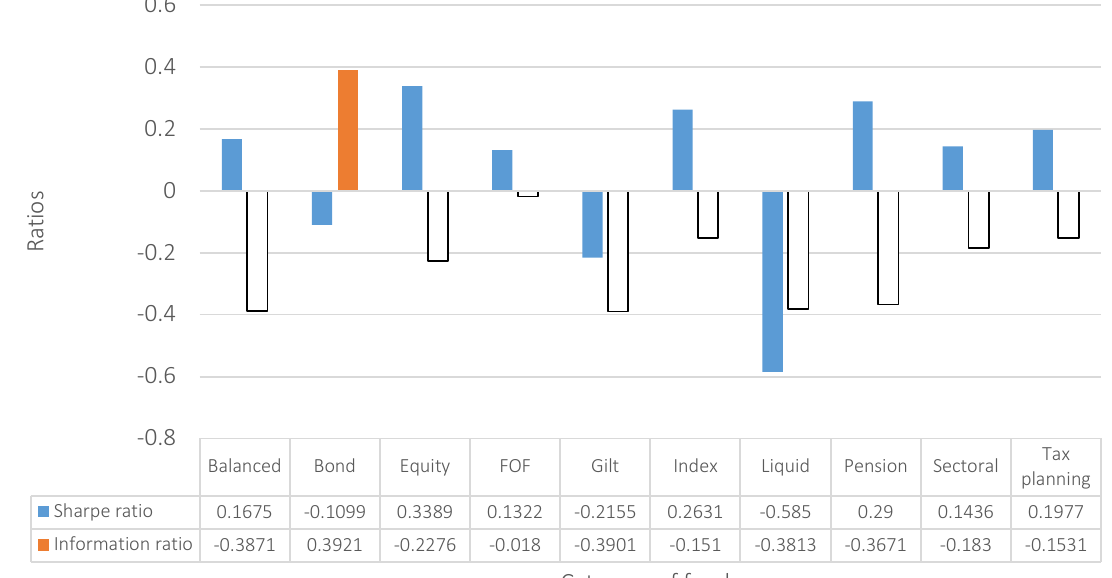
Figure 1. Sharpe ratio and Information ratio for different categories of